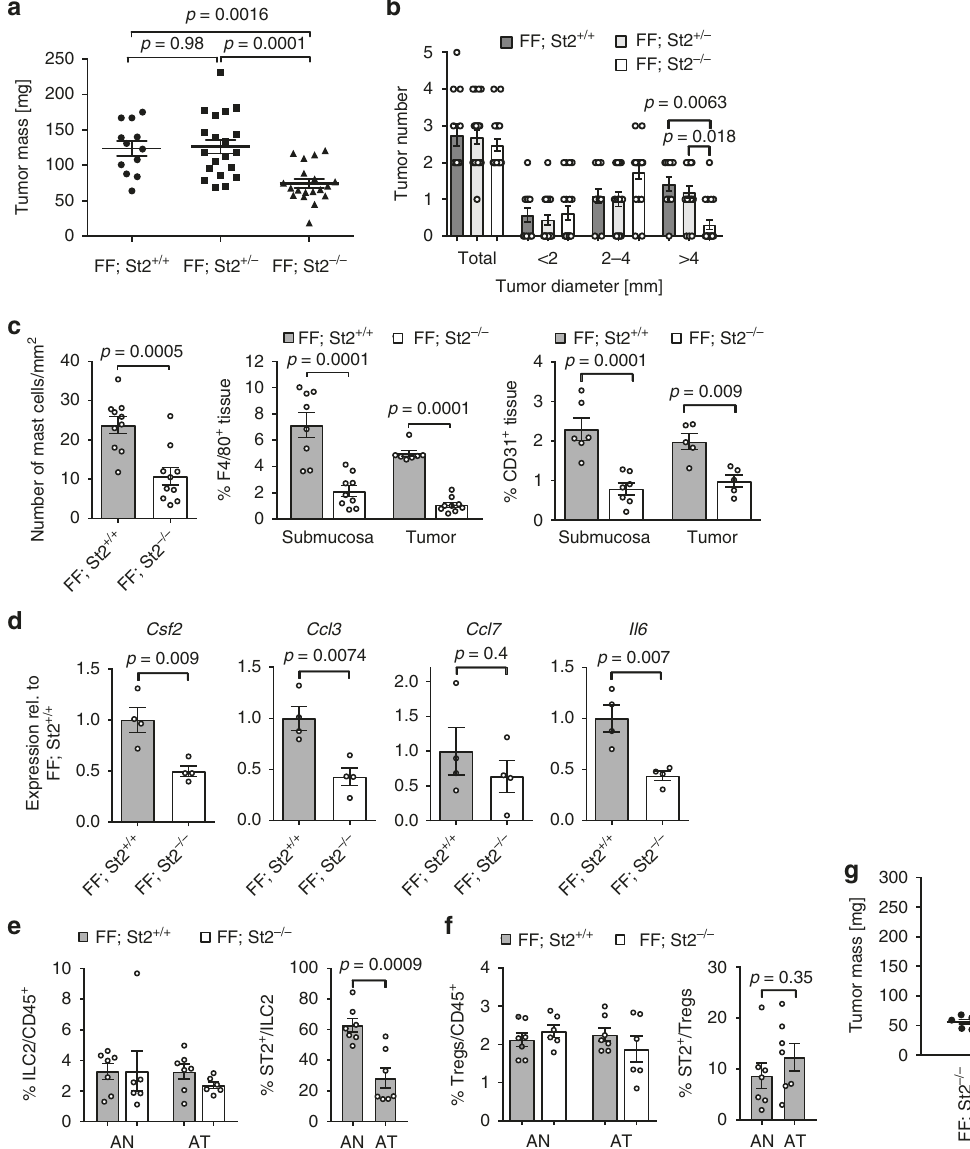
Fig. 7 Tumor burden is reduced in St2 receptor-de fi cient gp130 FF mice. a Quanti fi cation of total tumor burden in 100-day-old mice of the indicated genotype. Each symbol represents an individual mouse. One-way ANOVA was performed with F (DFn, Dfd) = 11.83 (2, 48). b Enumeration of total tumor number from mice in a , and of tumors following classi fi cation according to their size. n = 12 ( FF, St2 + / + ), n = 20 ( FF, St2 + / − ), and n = 19 ( FF, St2 − / − ) mice. One-way ANOVA was performed with F (DFn, Dfd) = 22.79 (11, 192). c Quanti fi cation of toluidine blue (for detection of mast cells; submucosal tissue), F4/80 and CD31 stained sections of gastric tumors of mice of the indicated genotype. Mast cells: n = 10 mice, t -test t (df) = 4.25 (18); F4/80: n = 8 (FF; St2 + / + ), n = 9 (FF; St2 − / − ), one-way ANOVA F (DFn, Dfd) = 27.52 (3,29); CD31: n = 6 (Submucosa) n = 5 (Tumor), and one-way ANOVA F (DFn, Dfd) = 13.6 (3,19). d qPCR expression analysis of chemokines expressed by FACS-puri fi ed tumor-associated mast cells from stomachs of either FF; St2 + / + or FF; St2 − / − mice. All n = 4 from two independent experiments. Csf2 : t -test t (df) = 3.81 (6); Ccl3 : t -test t (df) = 3.97 (6); Ccl7 : t -test t (df) = 0.88(6); Il6 :: t -test t (df) = 4.02 (6); e , f Flow cytometric analysis of unaffected antrum (AN) and antrum tumors (AT) of indicated genotype for the frequency of ILC2